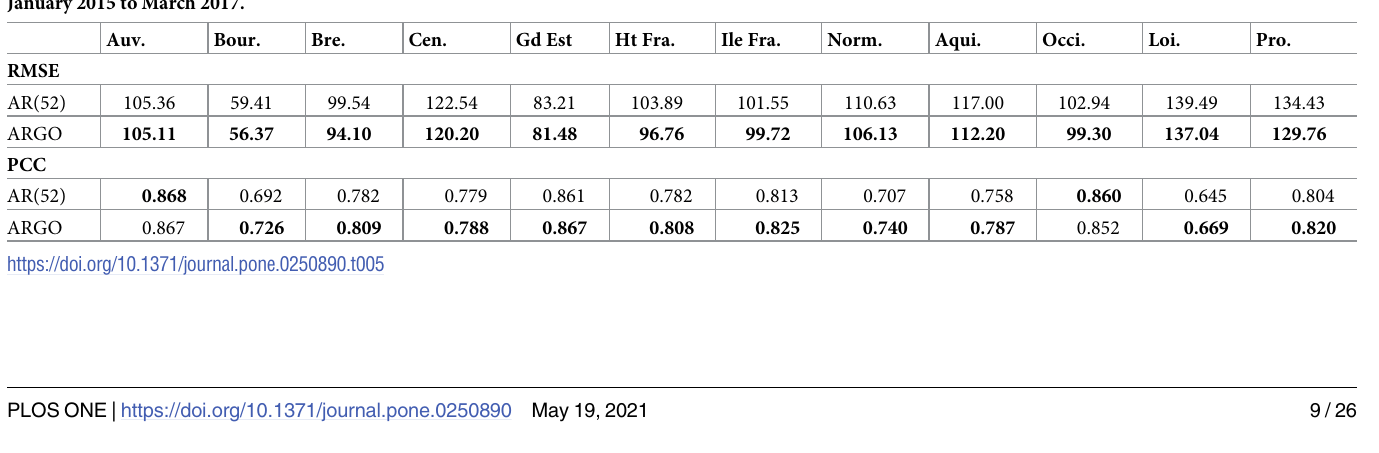
Climatic data . When combining climatic data with historical activity via ARGO was shown to consistently improve prediction results across all regions (Table 4). However, this improve- ment is lower than the one observed with EHR and Google data. Indeed, climatic data lead to correlation improvements of 2% for the region Pays de la Loire and decreases in error of 5% for the region Hauts-de-France. For one-week ahead estimate (Table 5), in term of correlation and error, results obtained with Climatic data are better or comparable for all regions. Climatic data lead to correlation improvements of up to 5% for the region Bourgogne-Franche-Comte´ and decreases in error of up to 7% for the region Hauts-de-France. For two-week ahead estimate (Table 6), results obtained with Climatic data are better for all the regions. Climatic data lead to correlation improvements of up to 25% and decreases in error of up to 11% for the region Bourgogne-Franche-Comte´. Twitter data . Overall, we found that national-level flu-related Twitter data improves pre- diction results for all regions.